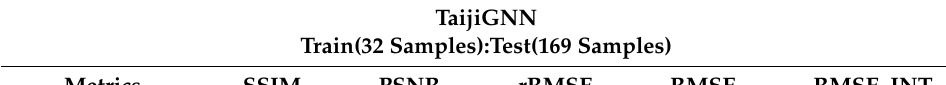
Table 9. The bi-directional translation outcomes of TaijiGNN on the ICVL database. TaijiGNN